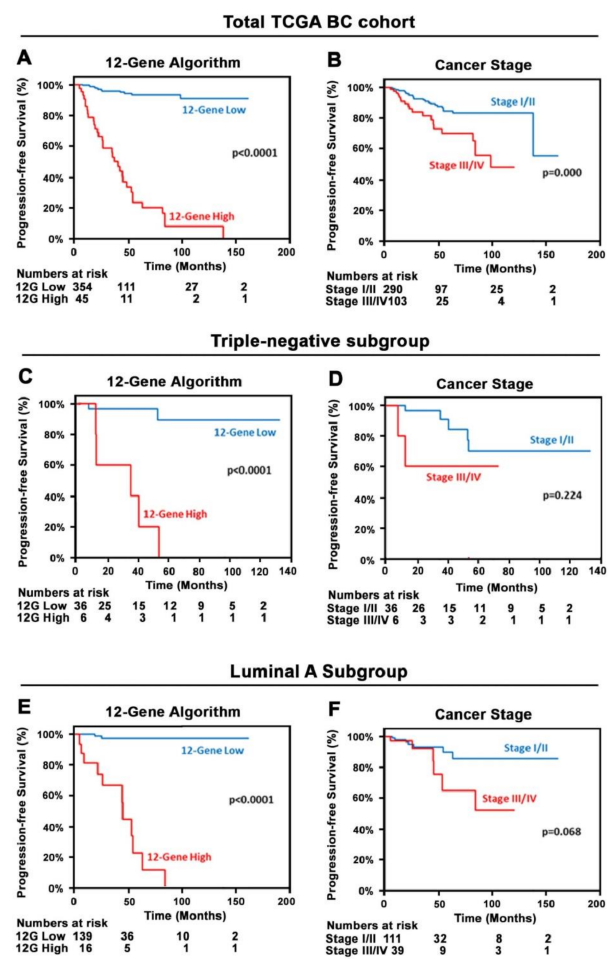
Figure 3. Kaplan–Meier survival analyses of the 12-Gene Algorithm and cancer stage for predicting PFS in the TCGA Cohort. ( A , B ) Kaplan–Meier survival curves of the 12-Gene Algorithm in ( A ) and cancer stage in ( B ) in the TCGA Cohort ( n = 399). ( C , D ) Kaplan–Meier survival curves of the 12-Gene Algorithm in ( C ), cancer stage in ( E ) in triple-negative patients ( n = 42) in the TCGA Cohort. ( E , F ) Kaplan–Meier survival curves of the 12-Gene Algorithm in ( E ) and cancer stage in ( F ) in luminal A patients ( n = 155) in the TCGA Cohort. Log rank p values are